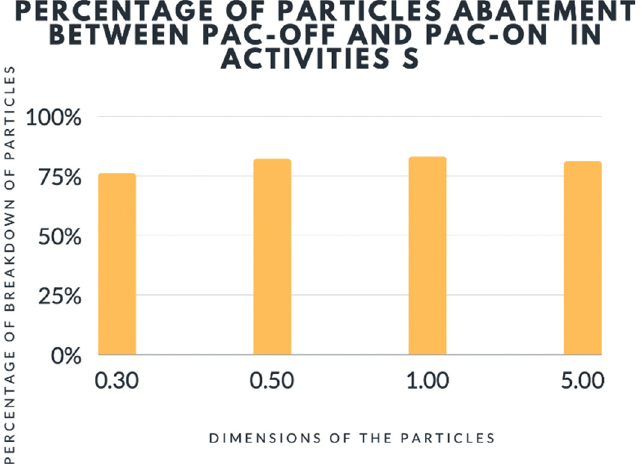
Figure 7. Analysis of particles during activity S with PAC off and on. PAC = Portables Air Cleaners.